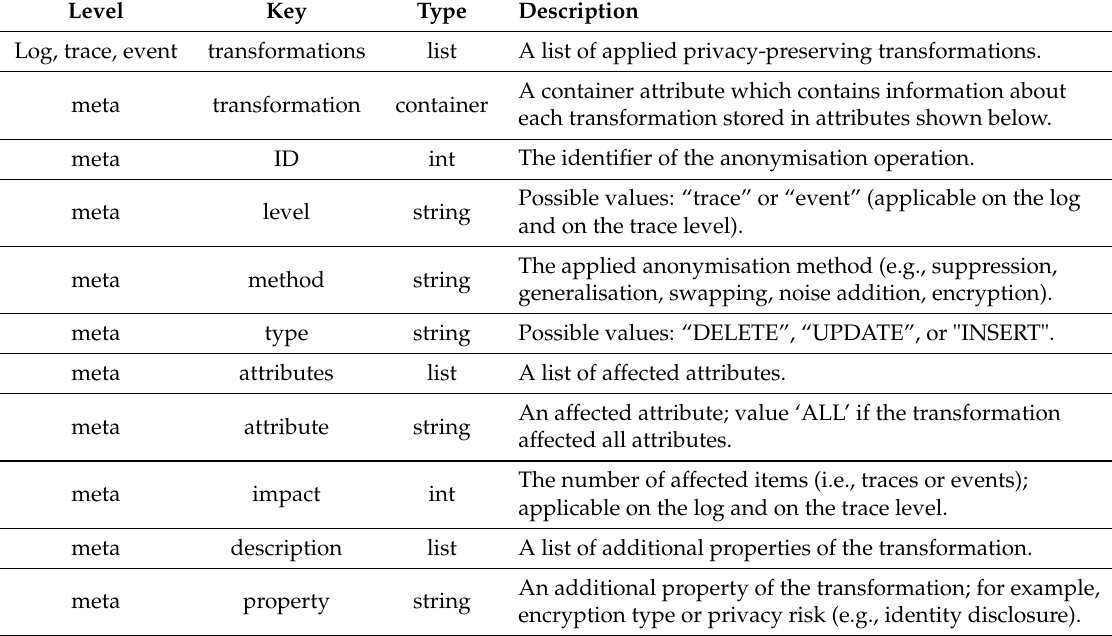
Table 5. Proposed privacy attributes.